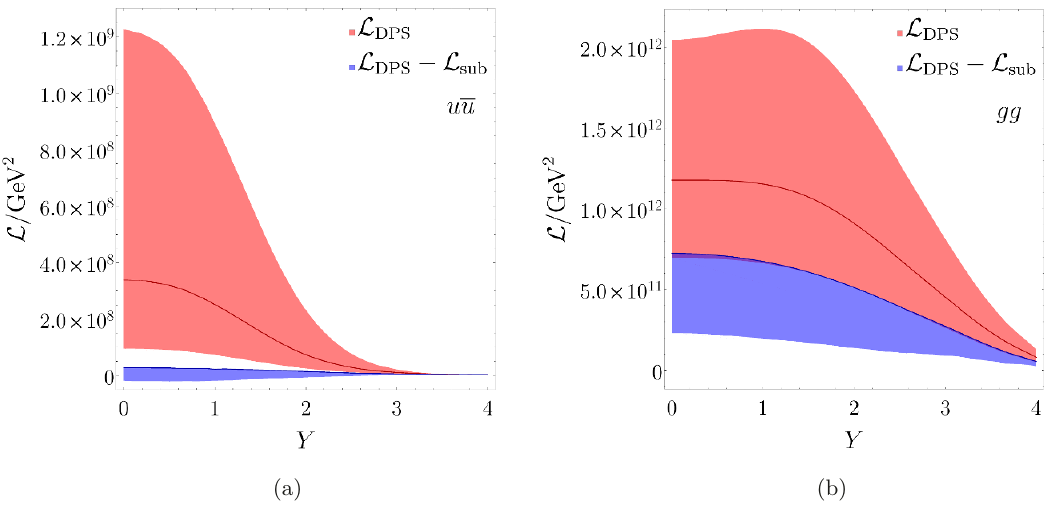
Figure 13 . DPS luminosity and the difference between the DPS and sub- L DPS L DPS − L 1v1,pt traction luminosities, shown for the u ¯ u (a) and gg (b) channels. Kinematic conditions are as in , the value for ν = 80 GeV is always at the top of the scale figure 12. In the case of L DPS − L 1v1,pt variation